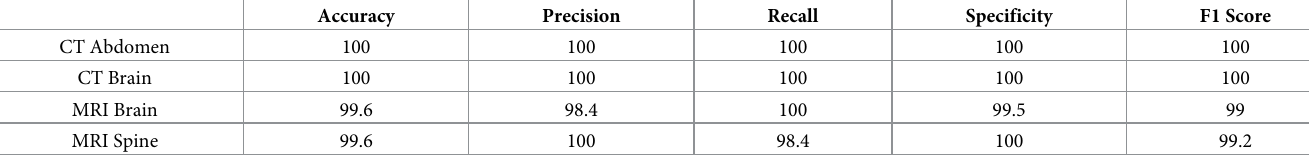
Table 6. Overall performance measures of our CNN architecture on testing set (In percentage).